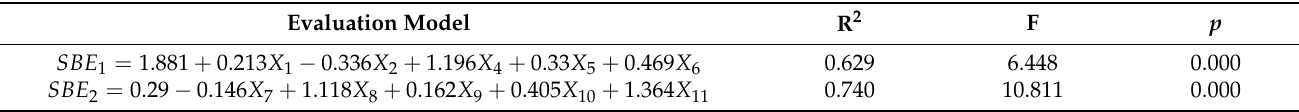
Table 7. Evaluation model of the degree of beauty of the CLF landscapes. Evaluation